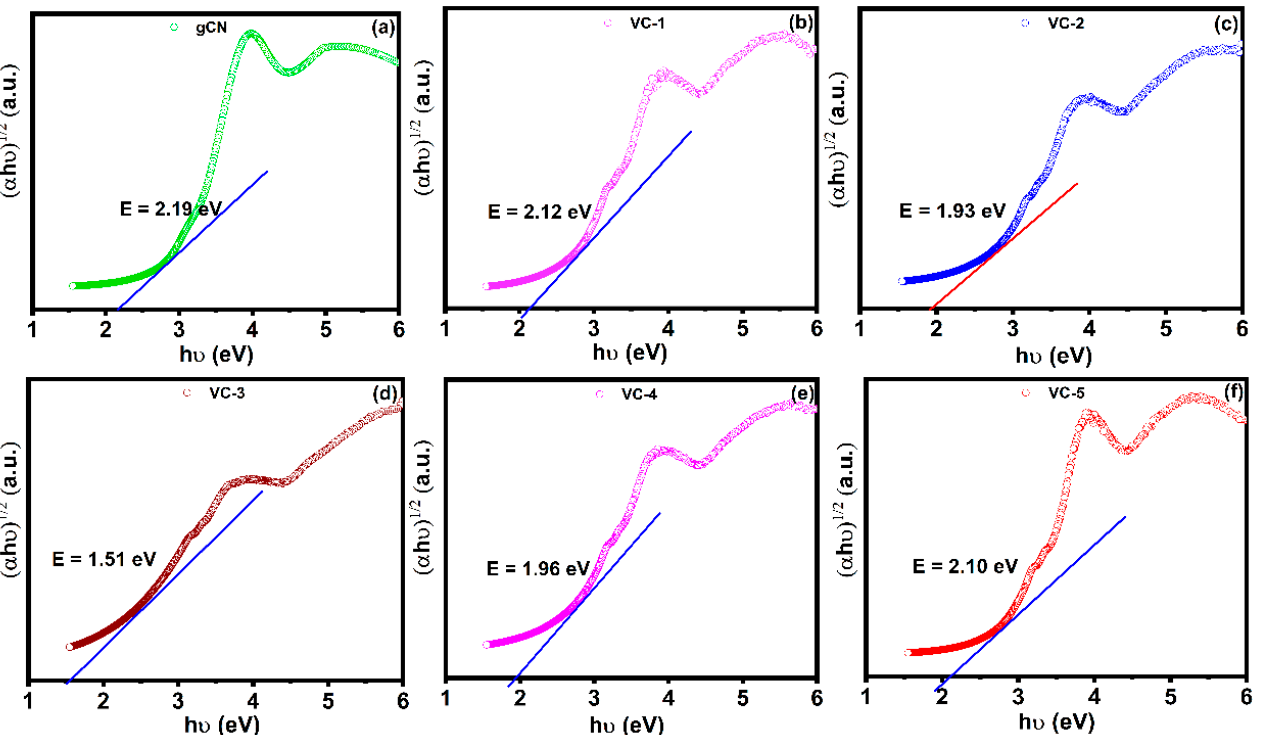
Figure 2. Tauc plots the bandgaps of all V/P/gCN nanosheets: ( a ) gCN, ( b ) VC-1, ( c ) VC-2, ( d ) VC- 3, ( e ) VC-4, and ( f ) VC-5. ( e ) VC-4, and ( f )